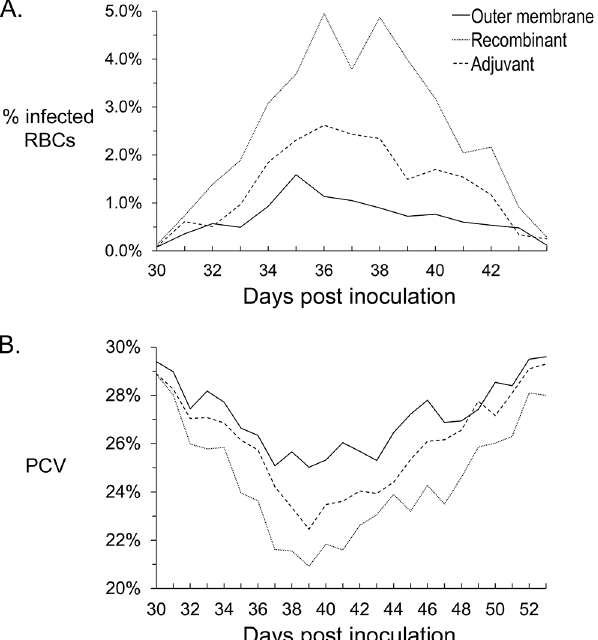
Fig 5. Percent infected erythrocytes and PCV in animals over time during challenge. The means of the percent infected erythrocytes (A) or PCV (B) for each group of animals are plotted by days post challenge. The AM854/AM936 vaccinates developed a statistically significantly higher percent of infected erythrocytes than the outer membrane vaccinates (p = 0.018). The differences in PCV were not statistically